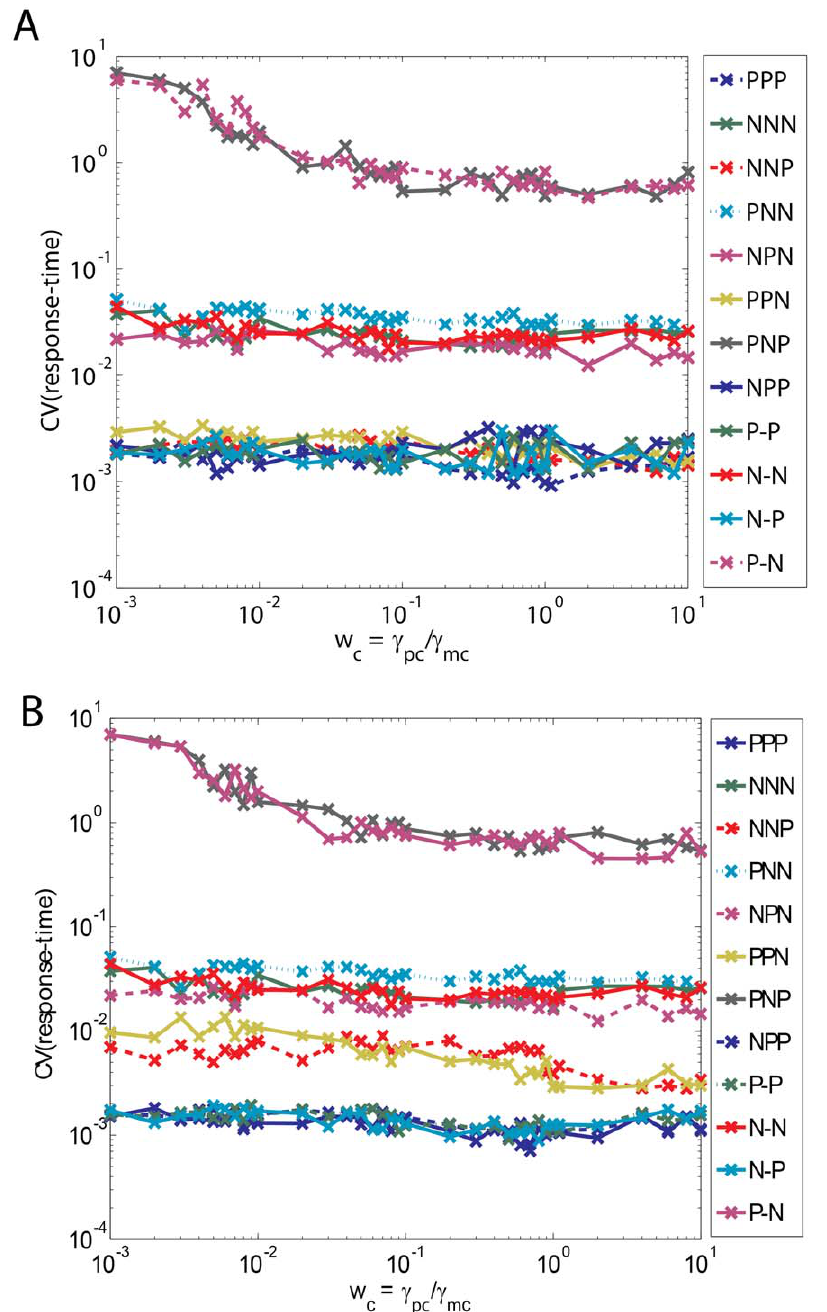
Figure 5. Coefficient of variation (CV) associated with the fluctuations in the response times of various types of FFLs under strong binding conditions ( (cid:2) mm =0.001). CV was calculated over 10 5 numbers of stochastic trajectories. The coherent C1 type FFL possesses lower CV of response times than other FFLs whereas I1 type possesses highest CV of response times. A. Here the settings are (cid:2) vv ƒ 0 : 003 that is applicable to both prokaryotes and eukaryotes such as yeast, (cid:2) ww was iterated from 0.001 to 10, and (cid:2) ss =4, T =25 generation times. B. Here the settings are (cid:2) vv § 0 : 03 that is applicable to higher eukaryotes such as human, (cid:2) ww was iterated from 0.001 to 10, and (cid:2) ss =4, T =25 generation times.